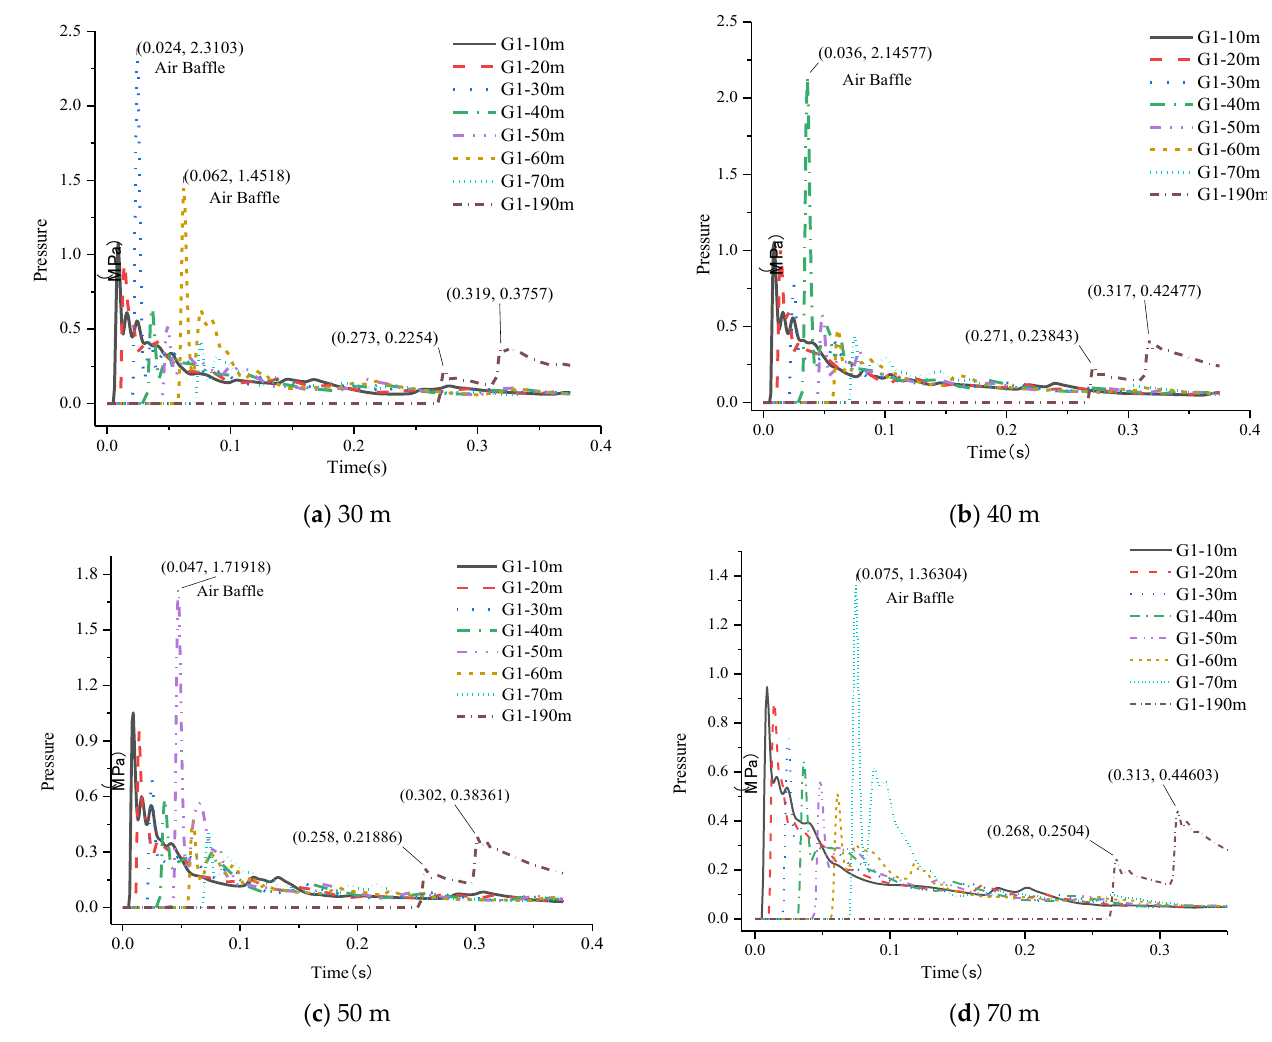
Figure 14. Overpressure- time curves of top of gas cabin with different gas baffle spacing .